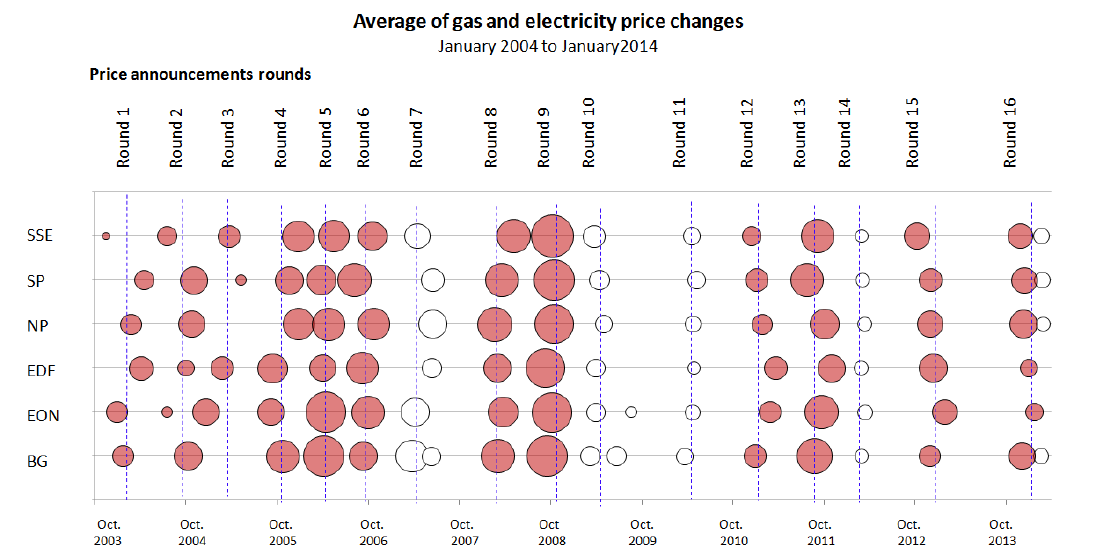
Figure 32: Average of gas and electricity price changes